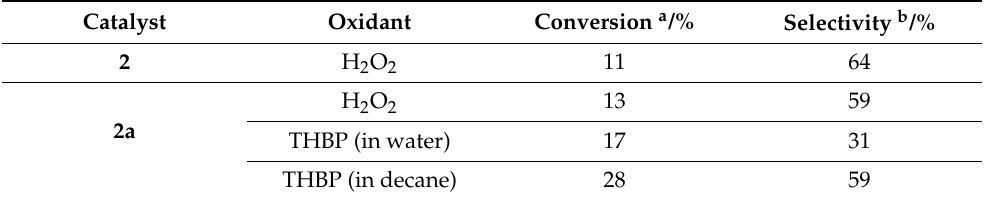
Table 3. Results of the cyclohexanol oxidation catalysed with molybdenum(VI) complex 2 and 2a in the presence of different oxidants after 5 h ( n (Mo): n (substrate): n (oxidant) = 1:400:800, T = 353 K). Catalyst Oxidant Conversion a